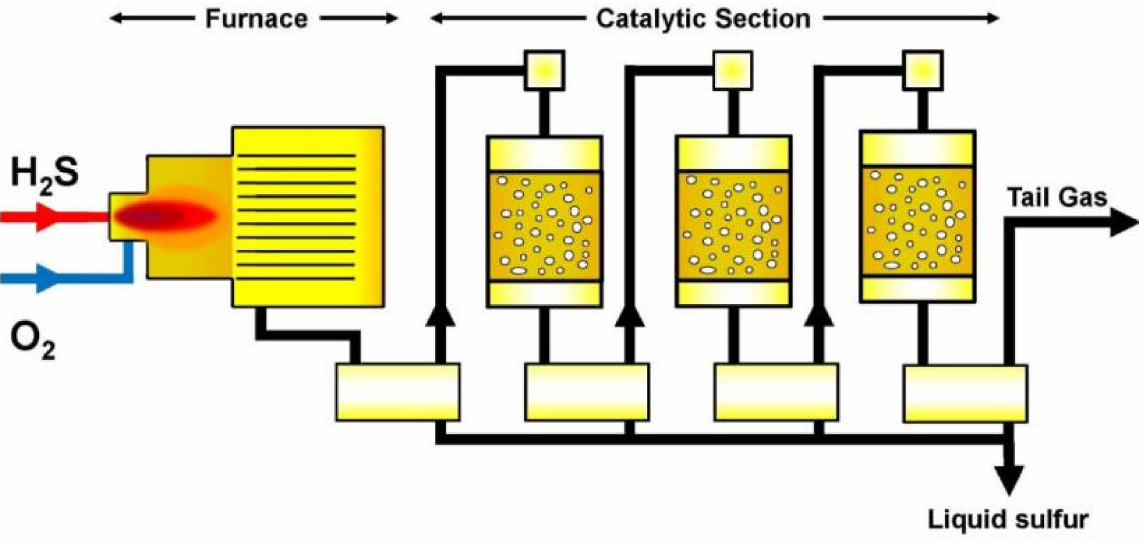
Figure 2. Schematic of Claus installation (adapted from [13]).